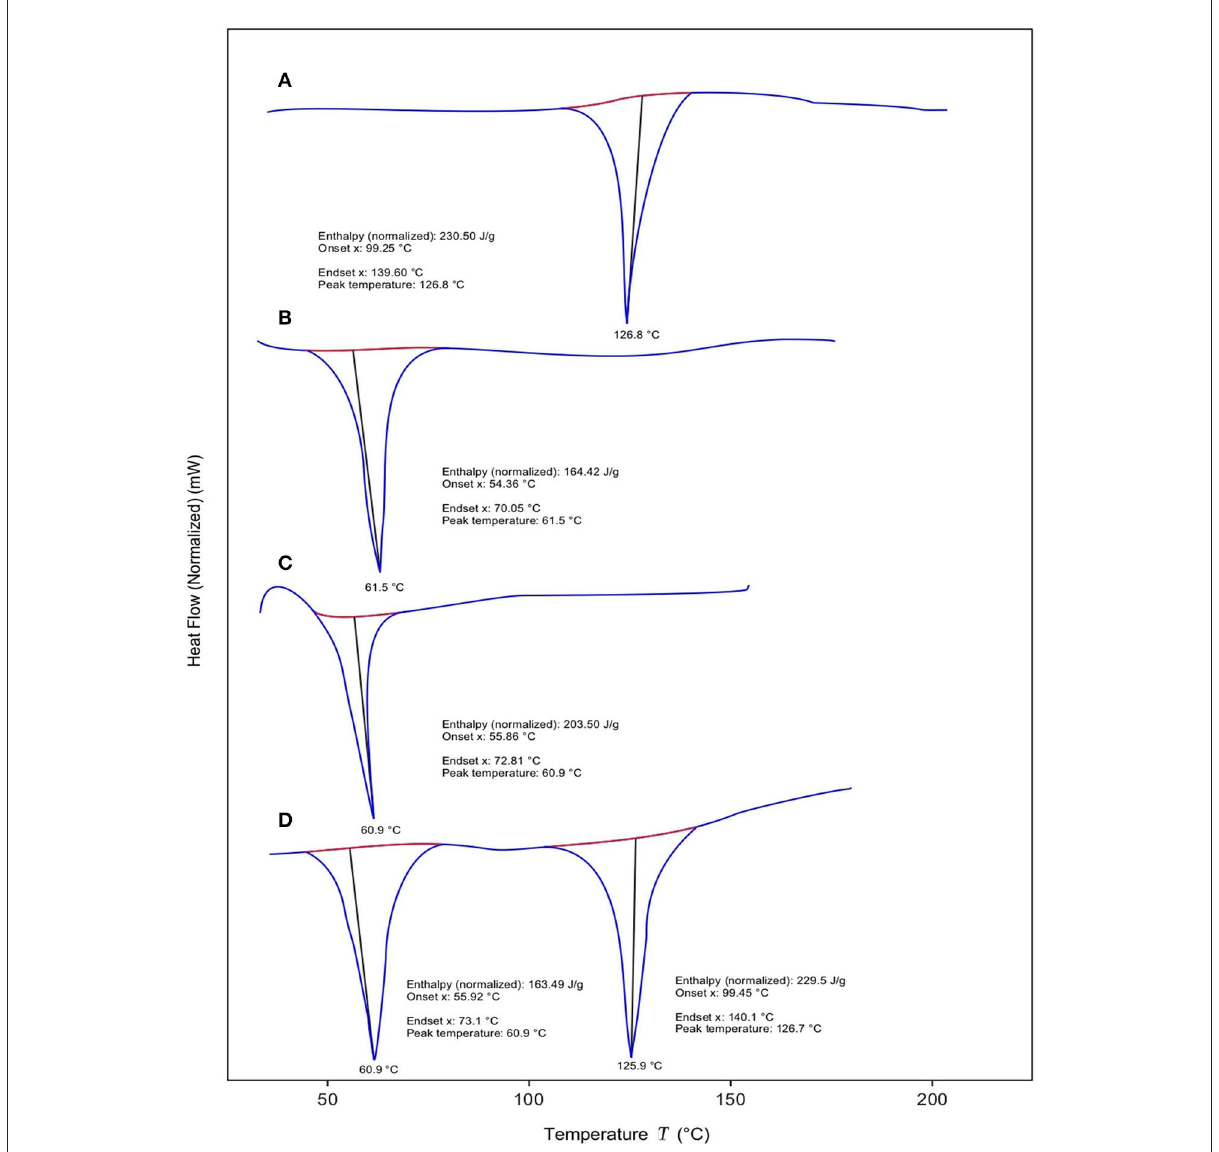
Figure 9 shows the flux and diffusion coefficients for RT- SLN and RT-Sol as 3.378g cm − 2 h − 1 and 0.310 cm − 2 h − 1 , respectively. A higher value of flux and diffusion coefficient in the case of RT-SLN highlights the higher penetration potential of lipidic nanoparticles, which further increased the solubilization tendency of the drug in the lipoidal membrane when compared to RT-Sol (Joshi et al., 2010). Also, the presence of surfactants worked as penetration enhancers and increased the permeability through the nasal mucosa, whereas RT-Sol has a low tendency to cross the lipoidal membrane owing to its hydrophilic